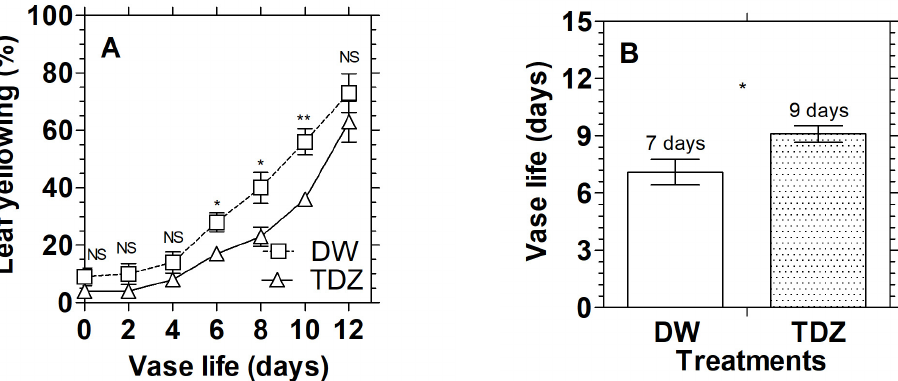
Figure 9. Effect of TDZ and MAP on yellowing of D. solida leaves after 1-week storage ( A ). Leaves were pulsed with 10 µ M TDZ and distilled water (DW; control), then packed in BOPP bag, and stored at 10 ◦ C under cool-white fluorescent lights for 12 h/d for 1 week. After storage, ferns were transferred to distilled water in a controlled environment room for the vase period ( B ). Asterisks (*) indicate significant differences between the two treatments after storage ( t -test; * p < 0.05, ** p < 0.01, NS not significant).